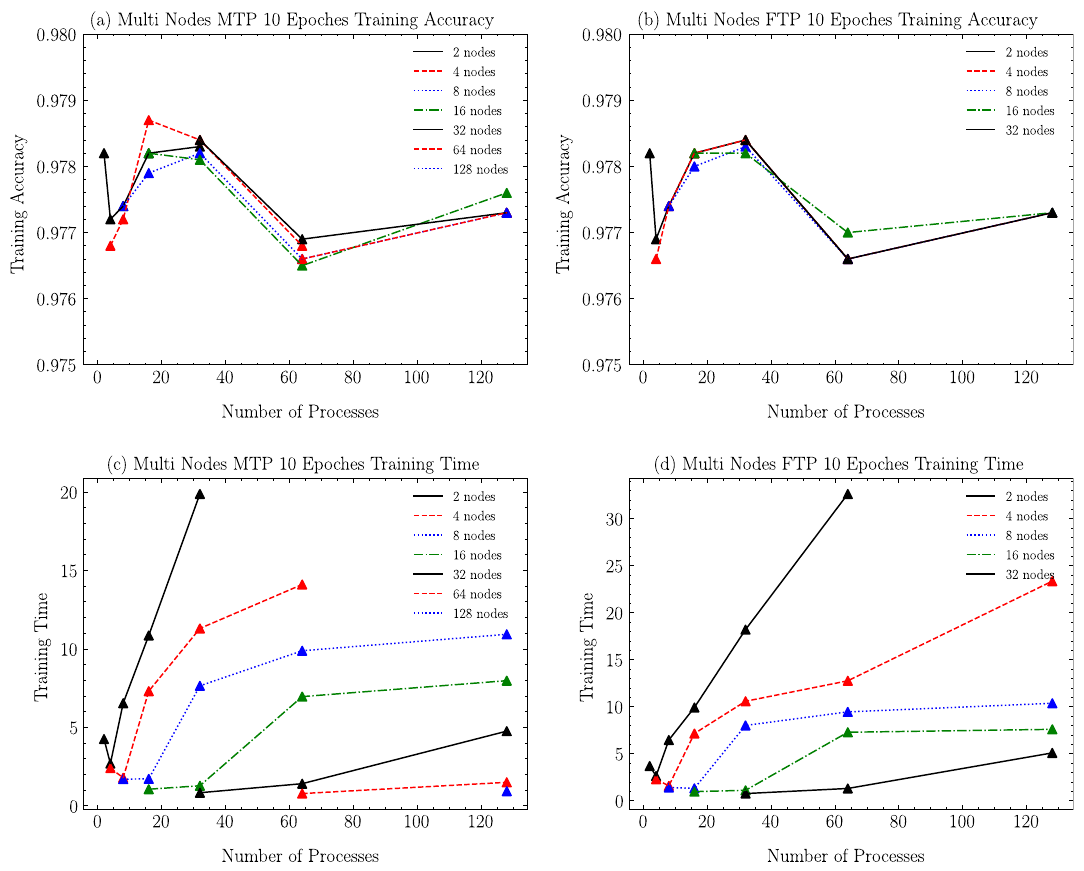
Figure 7. MT2000+ and FT2000+ multi nodes training loss and training time.